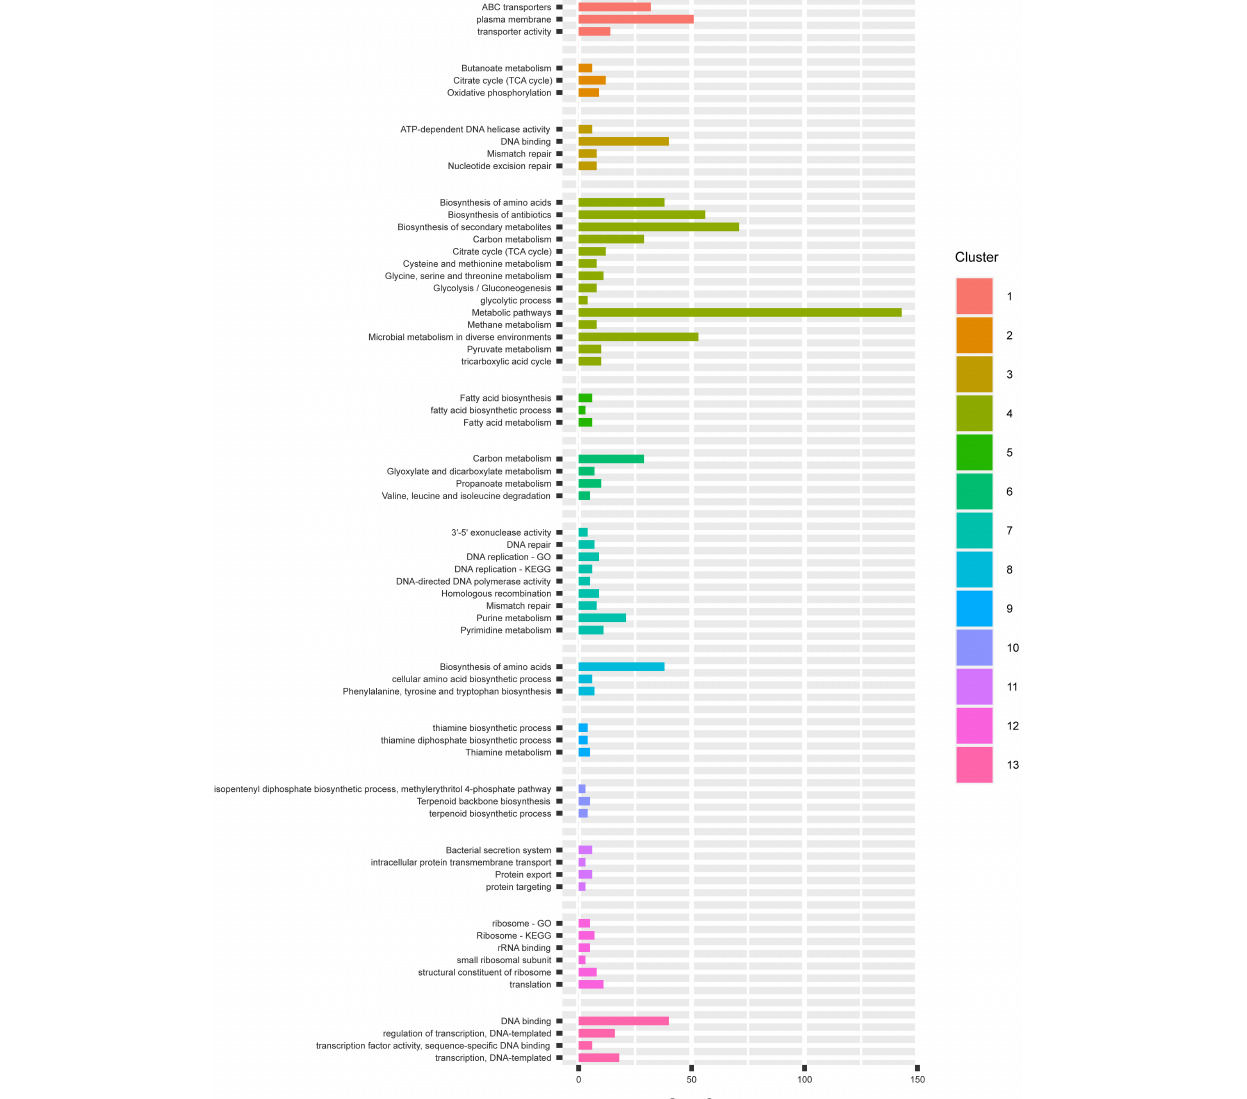
Frontiers in Bioengineering and Biotechnology |